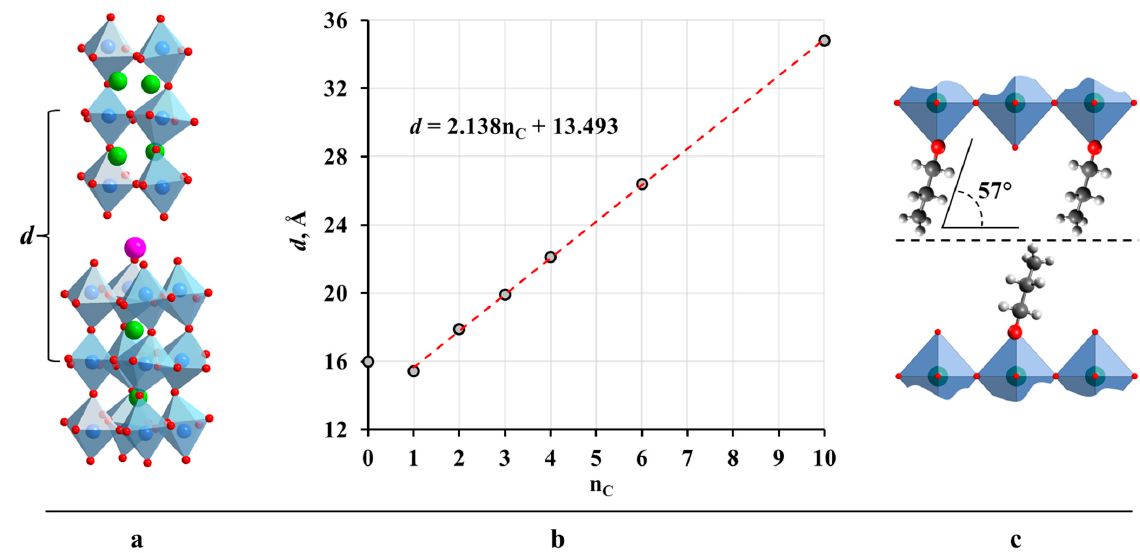
Figure 2. Crystal structure fragment of initial KCN 3 ( a ), correlation between the interlayer distance d and n -alkoxy chain length ( b ), model of a paraffin-like tilted organic bilayer ( c ).